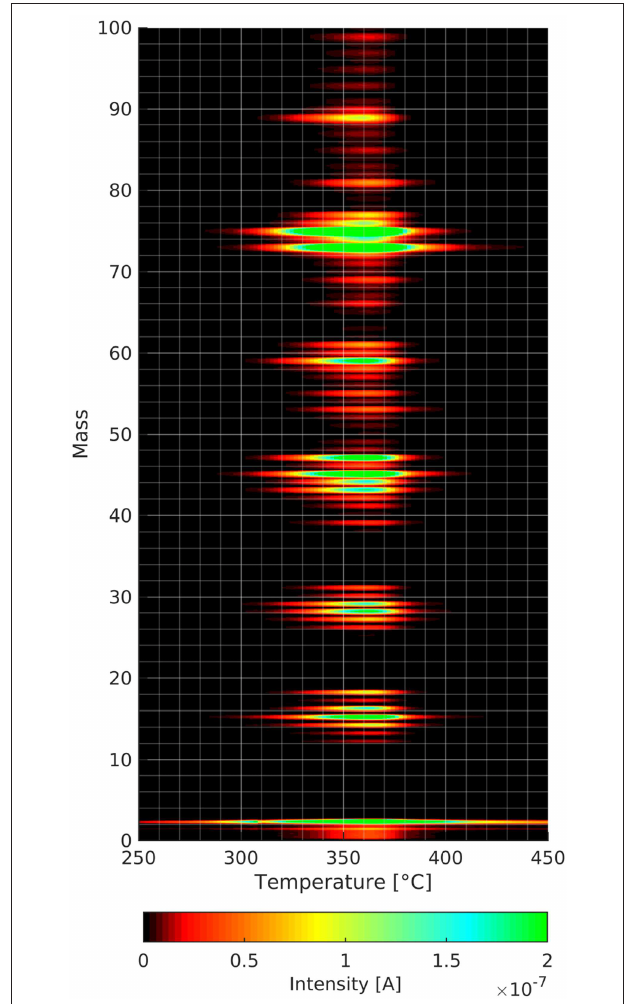
FIGURE 4 | Mass spectra as a function of temperature of the cellulose film decomposition and desorption. The intensities of the different masses are linked to the color